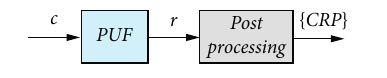
Figure 3: Establishing challenge-response pairs (CRP).